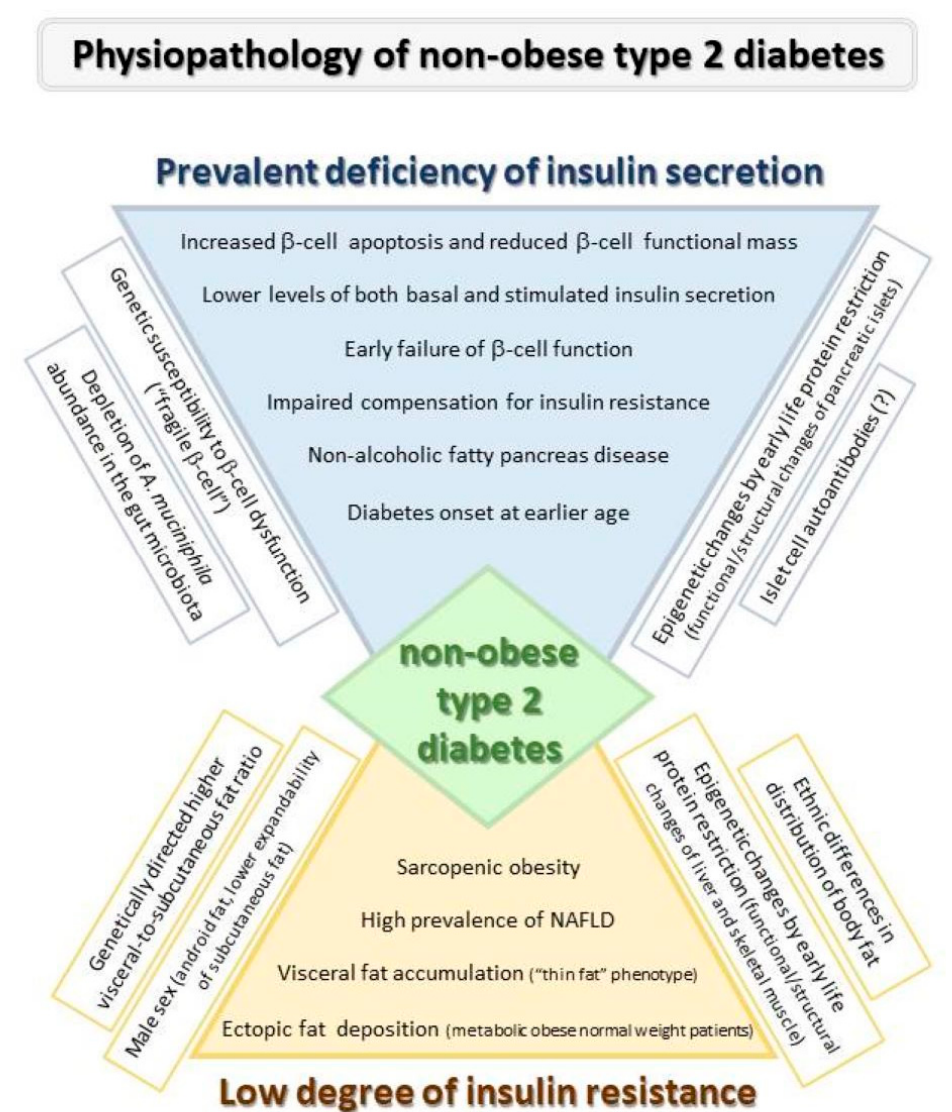
Figure 1. Pathophysiological characteristics of lean